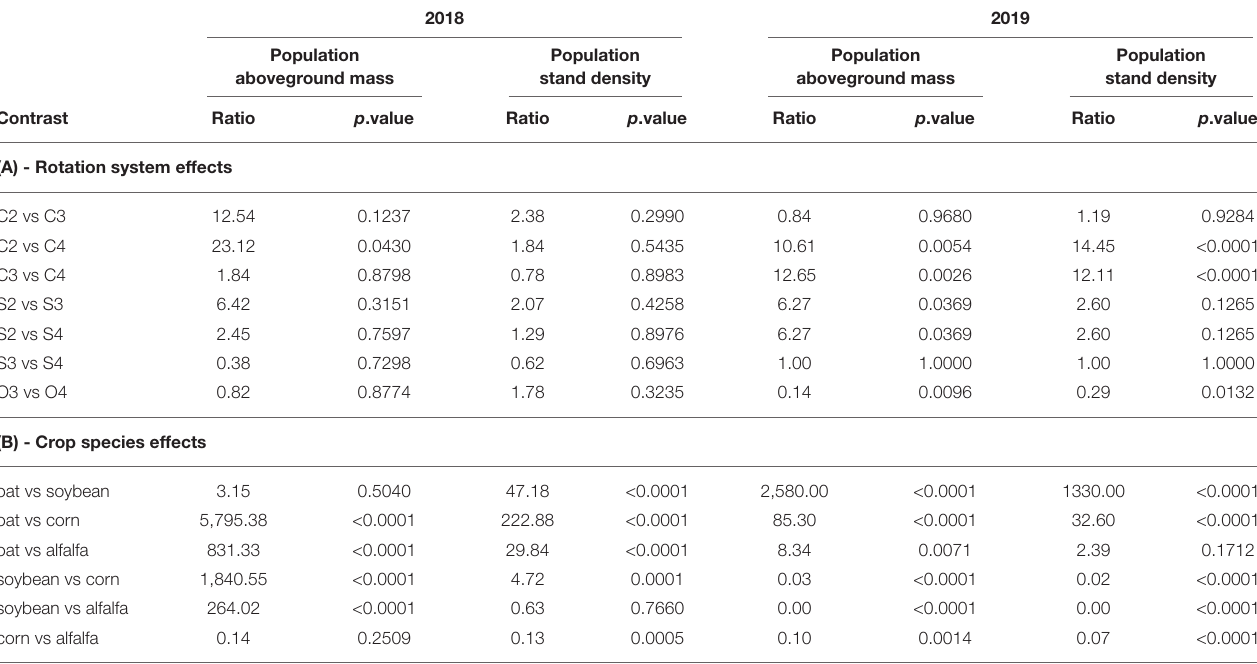
TABLE 5 | Rotation system and crop species effects on population aboveground mass and stand